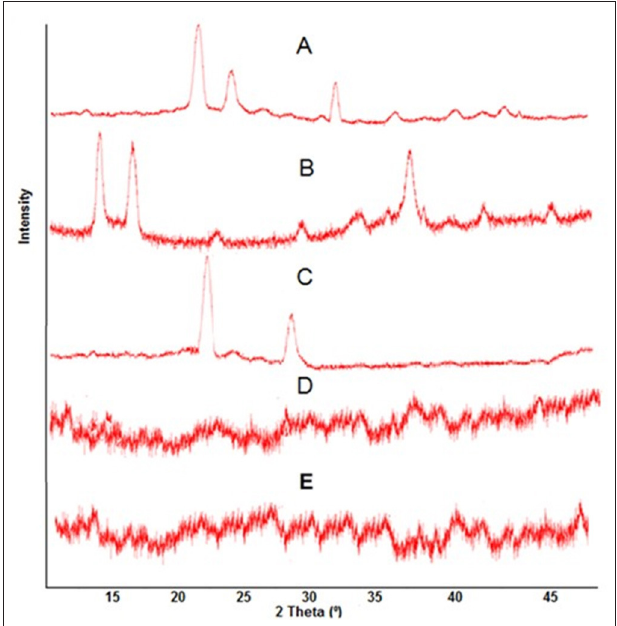
FIGURE 5 | PXRD pattern of (A) ACV, (B) CS, (C) XG, (D) ACV unloaded Hydrogel, and (E) ACV loaded